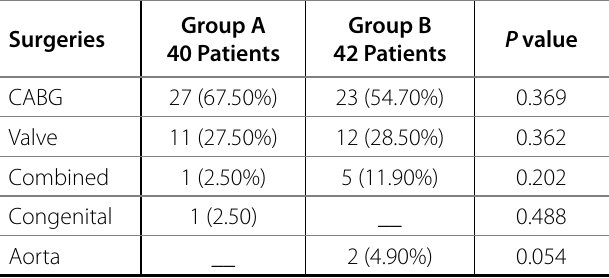
Table 2. Assessed surgeries (Group A vs. Group